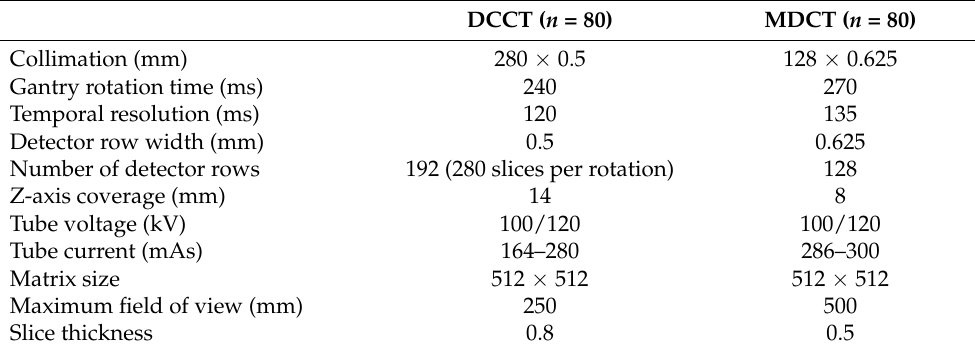
Table A1. Key specifications of the two CT scanners used in the study.